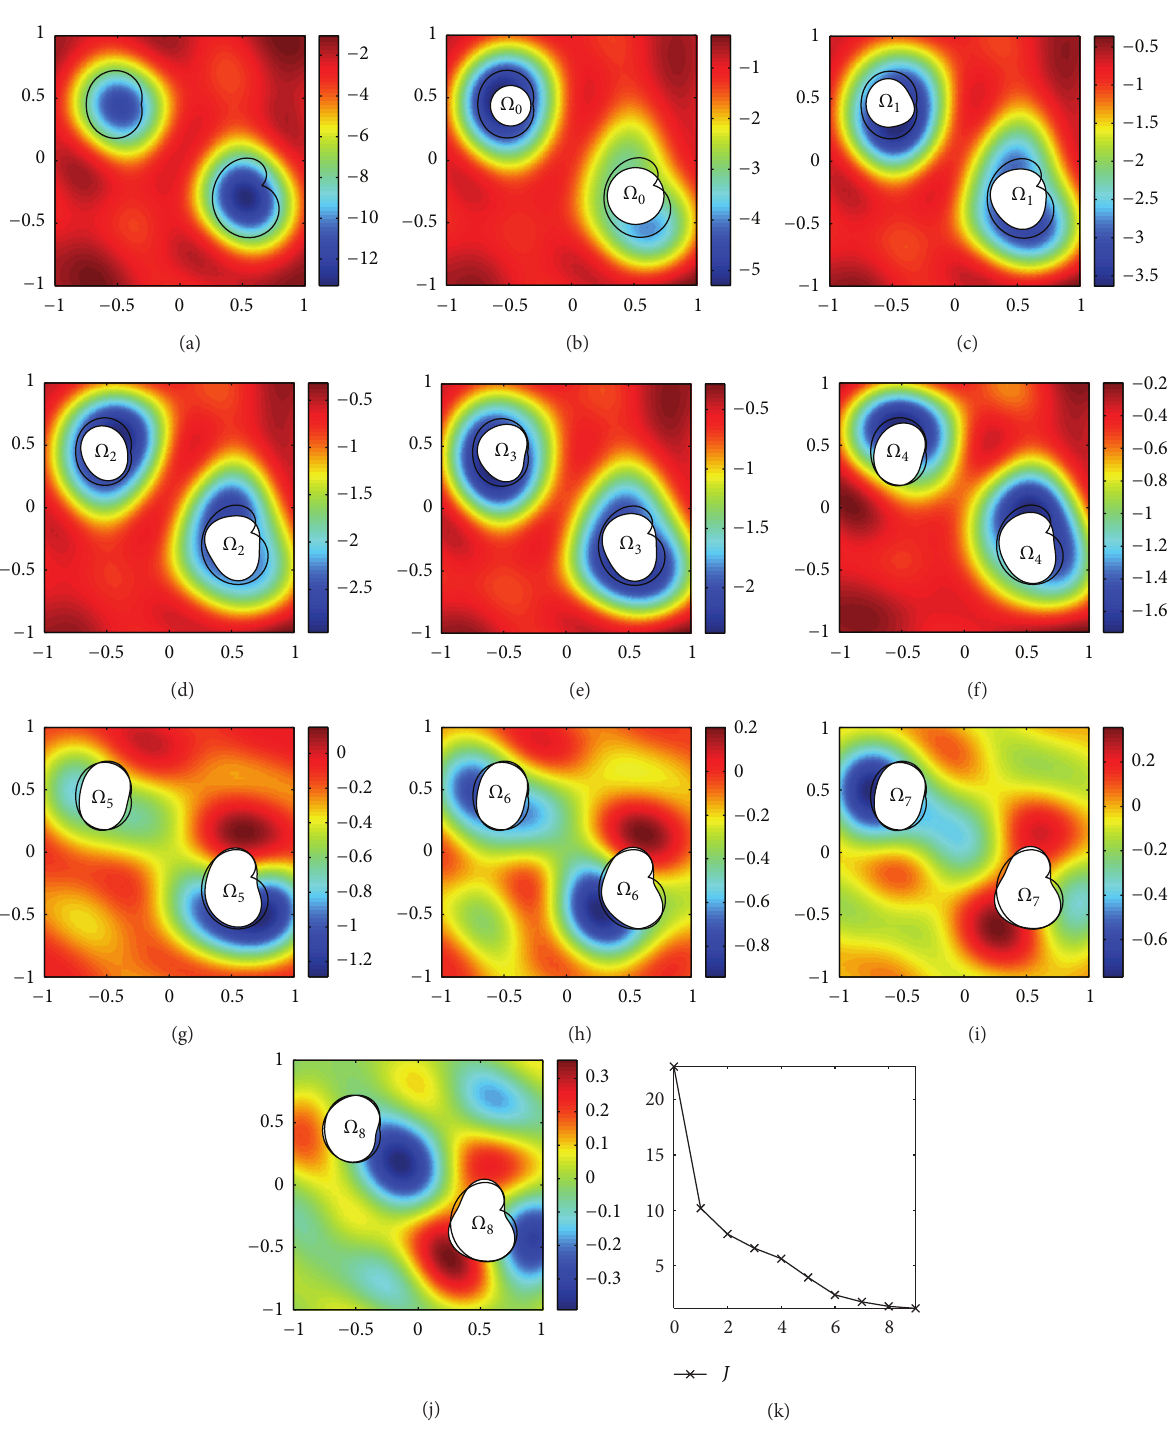
Figure 4: Reconstruction of objects when 𝑘 𝑖 = 1 is known using the monotone algorithm. (a) Topological derivative when Ω = 0 . (b)–(j) Approximate domains Ω 𝑚 superimposed to the topological derivative for Ω = Ω 𝑚 , for 𝑚 = 0, ...,8 . (k) Cost functional versus the number of